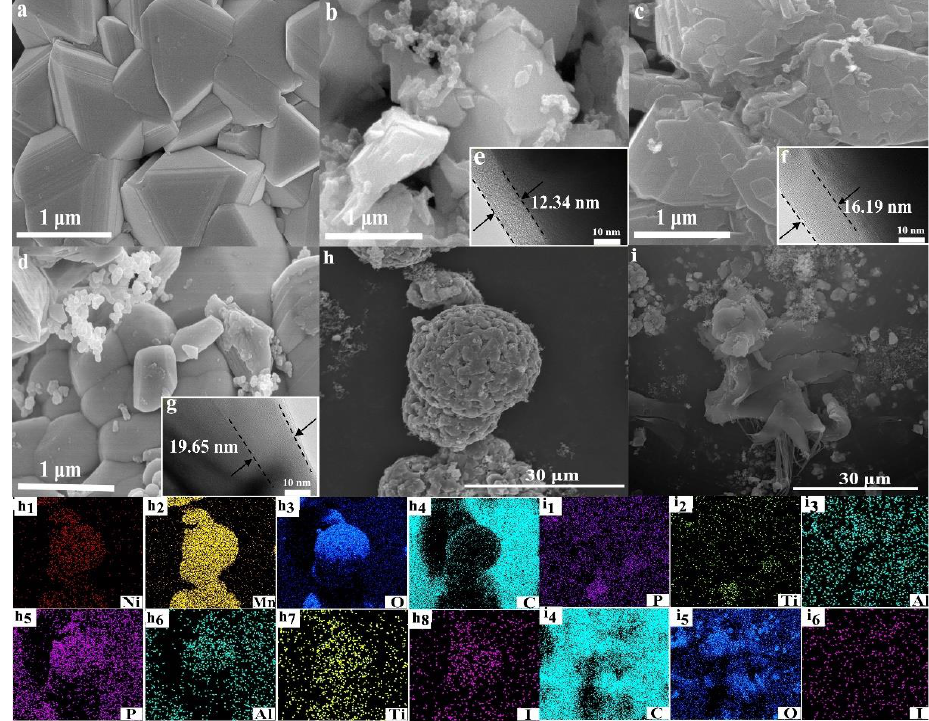
Figure 4. The SEM images (×40.0 K) of ( a ) the bare LNMO, ( b ) 2.5% LATP/C-LNMO, ( c ) 5% LATP/C-LNMO, ( d ) 7% LATP/C-LNMO, ( e – g ) the HRTEM images of LATP/C-LNMO , SEM with the corresponding EDS mapping images ( h 1 – h 8 and i 1 – i 6 ) for the area of ( h ) 5% LATP/C-LNMO and ( i ) LATP.